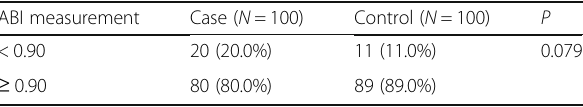
Table 1 Comparison between case and control groups about abnormal ABI ABI measurement